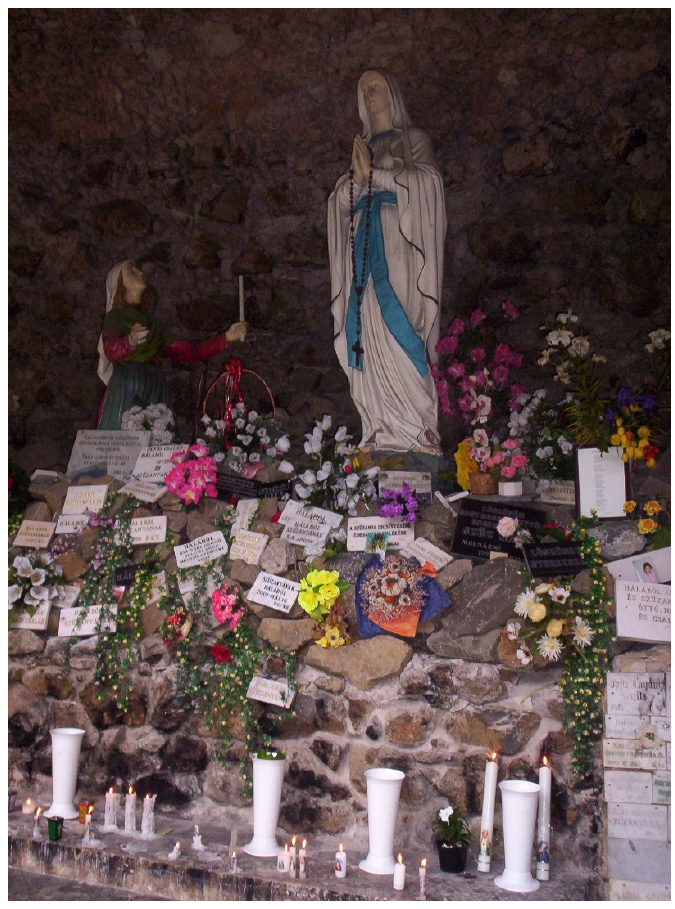
Figure 10. Gratitude tablets in Mátraverebély-Szentkút, Photo taken by Krisztina Frauhammer, 2008.